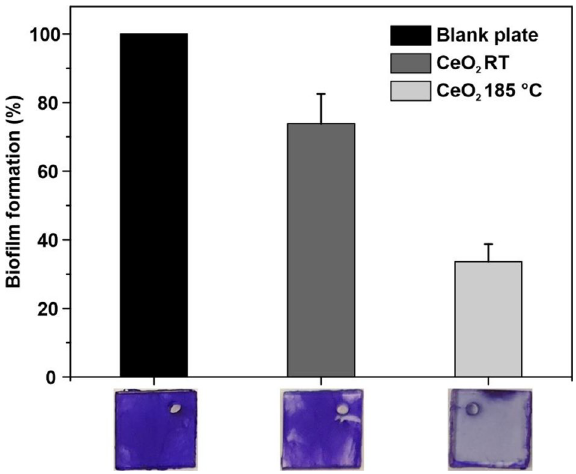
Figure 6. Bacterial biofilm formation on CeO 2 -coated PC surfaces. Crystal violet staining assay of P. aeruginosa PA14 grown in LB broth. The bacteria were cultivated aerobically for 72 h under gentle movement (150 rpm) at 30 °C on non-coated (blank plate) and CeO 2 -coated PC surfaces annealed at 185 °C or not annealed (RT). Then, the planktonic cells were removed, and the attached cells were stained with crystal violet. After solubilization of the bound crystal violet, the quantification was performed via measurement of absorbance in a plate reader at 575 nm. The stained plates are shown at the bottom of the figure. Error bars represent the standard deviation of three independently performed